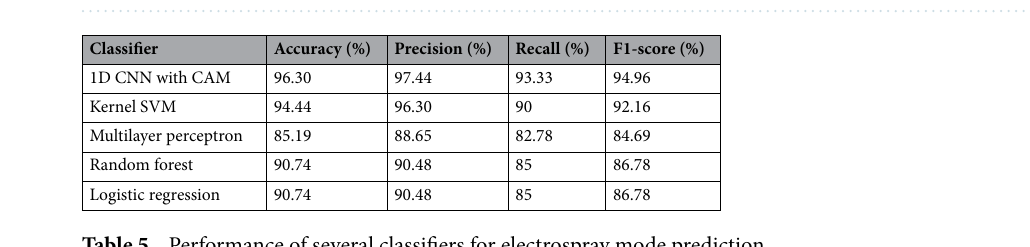
Figure 8. ( a ) Training result of 1D CNN with CAM and ( b ) confusion matrix for all datasets.